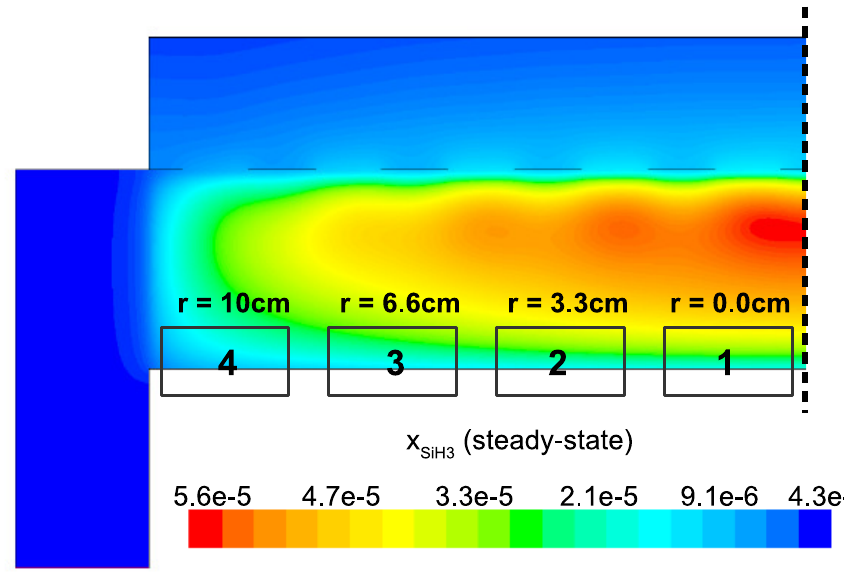
Figure 23. Four discrete locations across the wafer surface in which a representative thin film layer will be grown in order to investigate non-uniformities in the amorphous product.